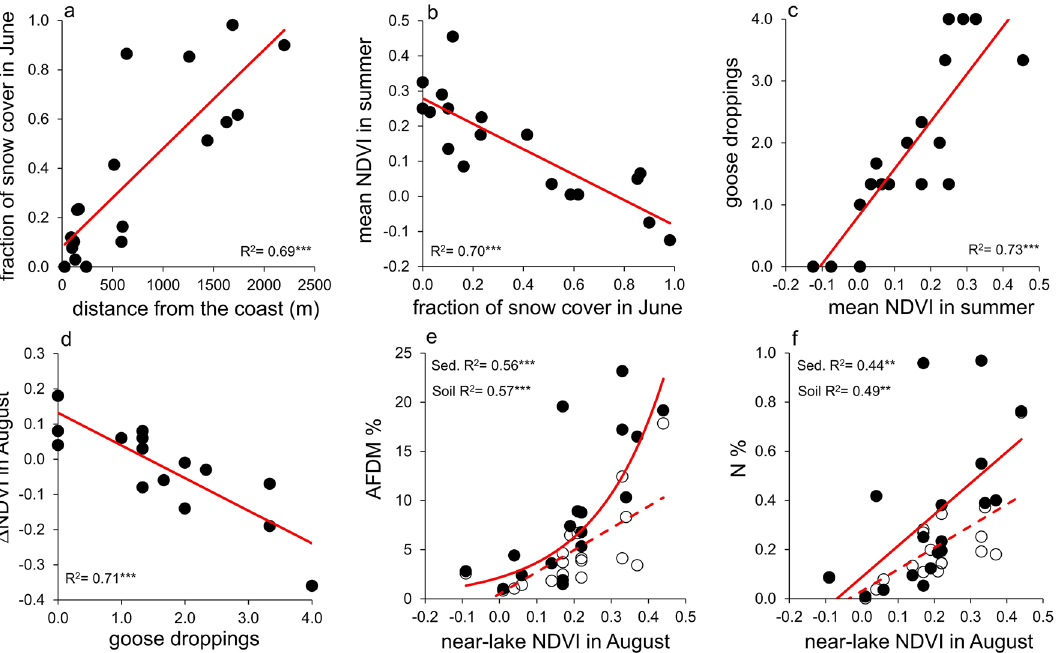
Figure 2. Correlations between abiotic and biotic variables measured in 18 shallow Arctic lakes. “Fraction of snow cover in June” refers to the fraction of each catchment area covered by snow at the beginning of summer. Mean NDVI in summer refers to the mean NDVI value from June to August. ΔNDVI refers to the difference between near-lake NDVI and catchment area NDVI in August (see "Methods" section). The relative amount of goose droppings, as a proxy for geese abundance, is expressed via non-integer values ranging from 0 (absent) to 4 (very high). Black and empty symbols in panels ( e – f ) indicate values in sediment and soil respectively. Asterisks denote the significance level: **: p < 0.01, ***: p < 0.001. See Appendix 1 in the online supplementary material for model details.